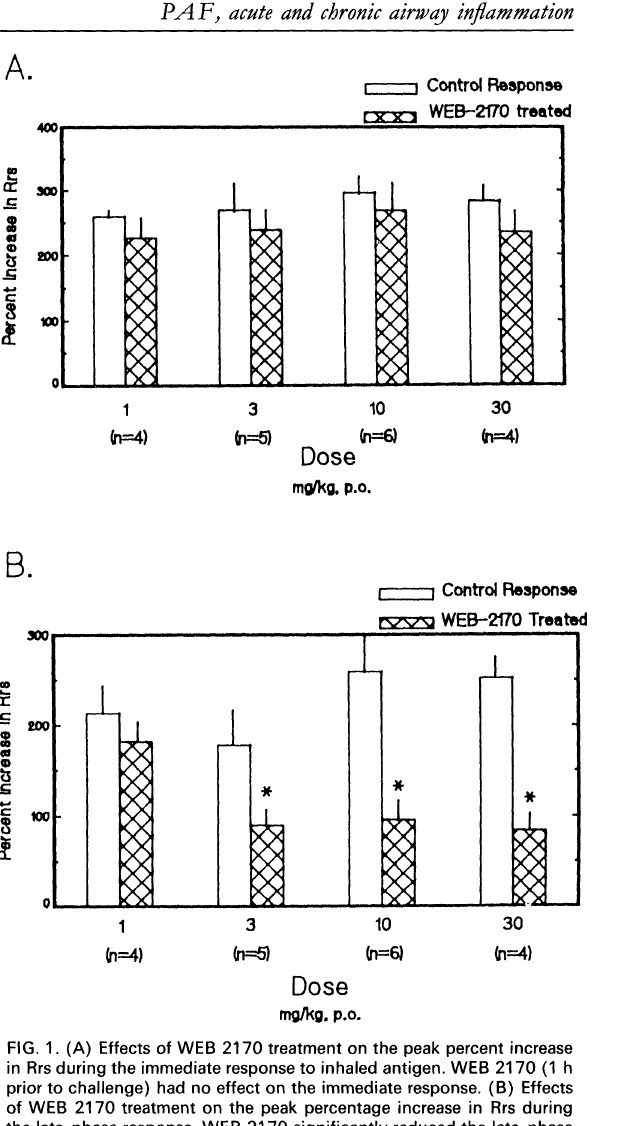
FIG. 1. (A) Effects of WEB 2170 treatment on the peak percent increase in Rrs during the immediate response to inhaled antigen. WEB 2170 (1 h prior to challenge) had no effect on the immediate response. (B) Effects of WEB 2170 treatment on the peak percentage increase in Rrs during the late-phase response. WEB 2170 significantly reduced the late-phase response at 3, 10 and 30 mg/kg doses. *Indicates statistical significance (p <